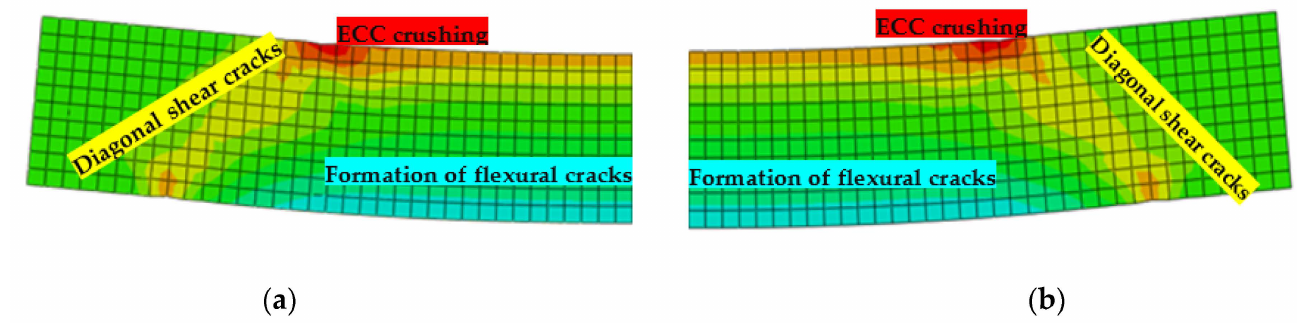
Figure 16. Plastic strain distribution for beams: ( a ) S-1; ( b )